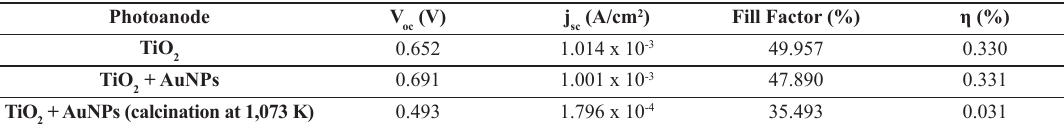
cells with or without gold nanoparticles via wet impregnation. Table 6. j x V curve results of TiO 2 Photoanode